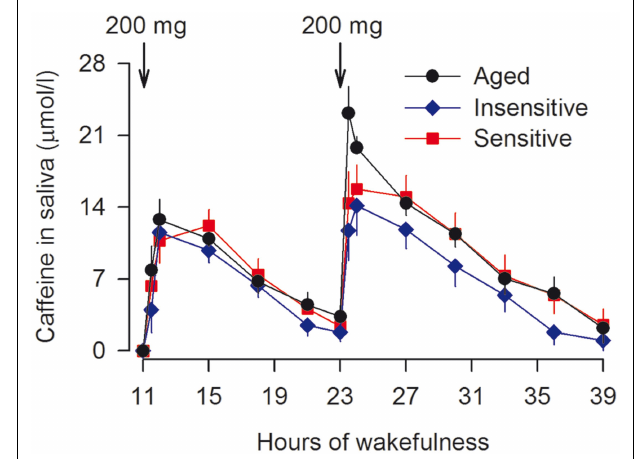
FIGURE 6 | Similar time course of saliva caffeine concentration in aged ( n = 10, black dots) and caffeine-insensitive ( n = 9, blue diamonds) and -sensitive subjects ( n = 11, red squares) young men. Samples were collected 5min before and 30 and 60min after caffeine intake, and at 3-h intervals following the first dose of caffeine.The data of 1 caffeine-insensitive and 1 caffeine-sensitive individual could not be analyzed because of insufficient saliva volumes.Values represent means ± SEM. Mixed-model ANOVA with the factors “ group ” (aged, insensitive, sensitive) and “ time ” (14 measurements) revealed no significant difference among the groups (“ group ” × “ time ” interaction: F 2,26 = 1.2, p >